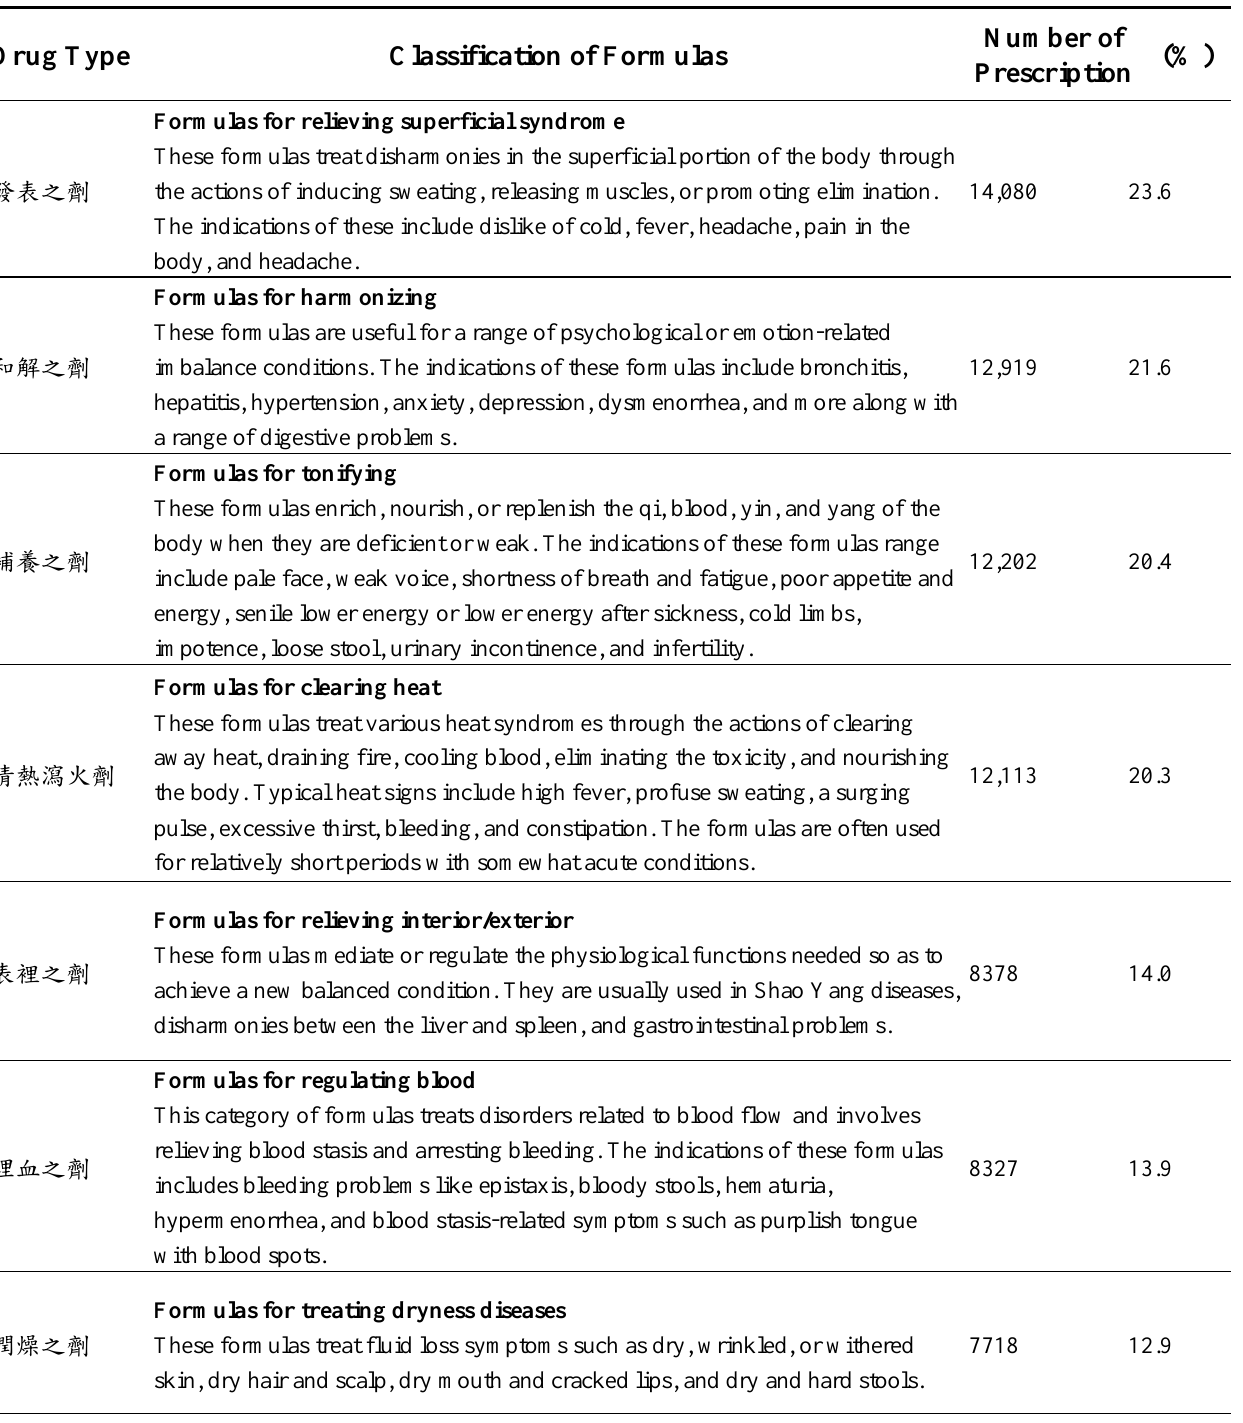
Table 4. The frequency of Chinese herbal formulas (HFs) prescribed by classifications in Taiwan in 2010 (total prescription number n =